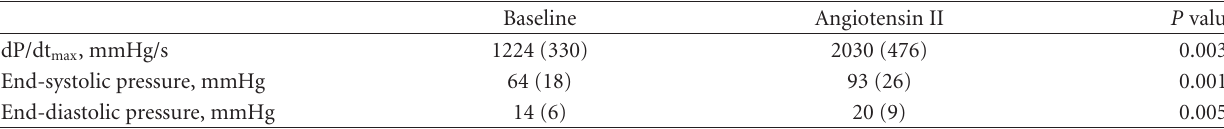
Table 3: Fetal left ventricular pressures at baseline and during angiotensin II infusion. Data are presented as mean